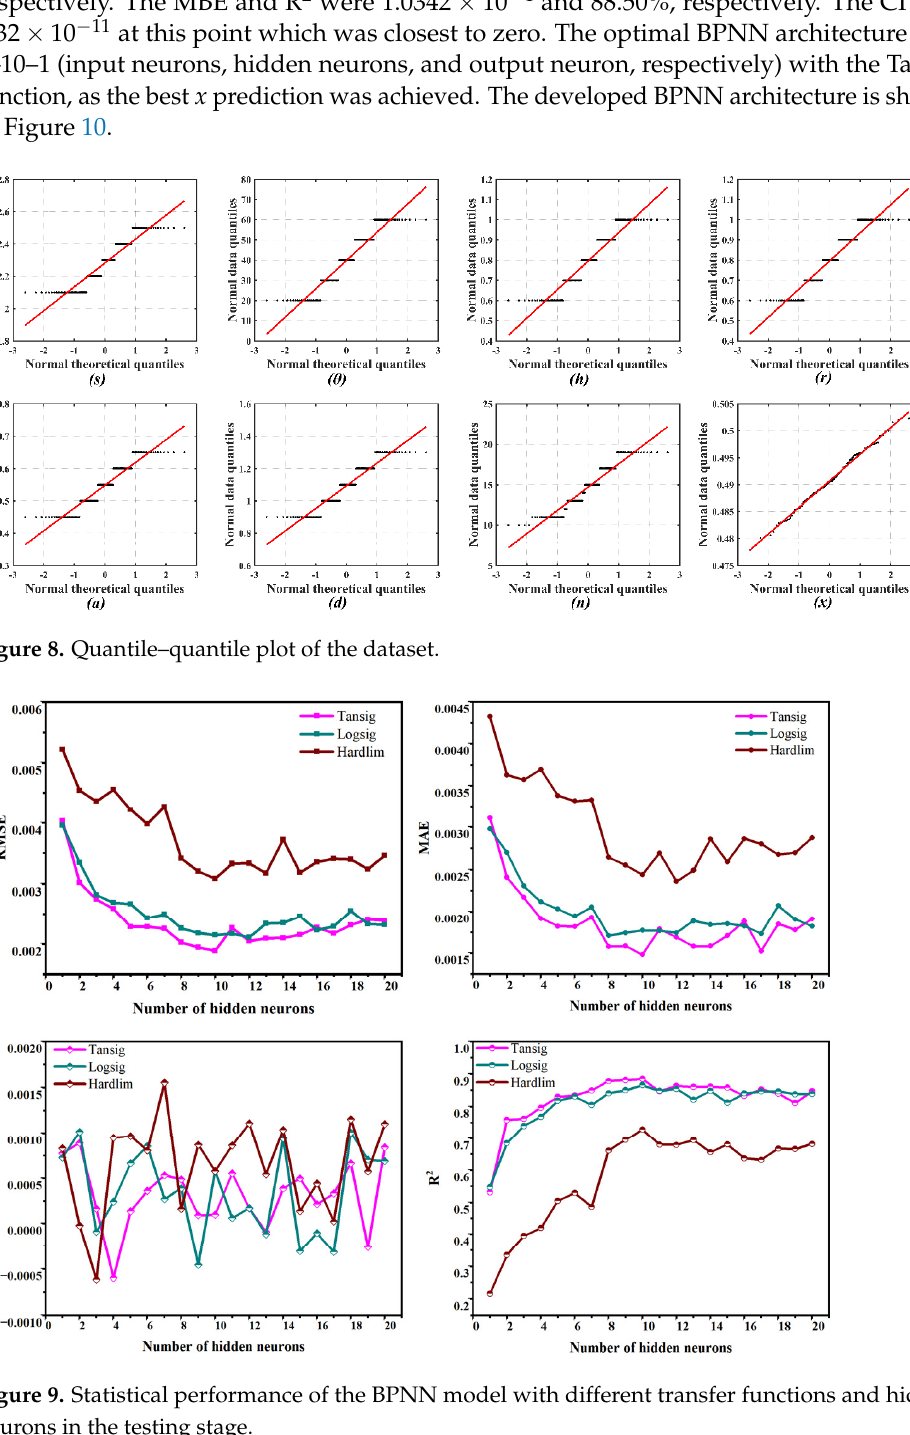
Figure 10. Optimal architecture of the developed BPNN model. 3.4. Performance of ELM Model The influences of different transfer functions and the number of neurons in hidden layer on ELM model were also studied in order to determine the optimal model struc ‐ ture. In the training process, when the number of neurons in the hidden layer ranges from 1 to 10, the model gave a poor x prediction (the values of RMSE and MAE were too